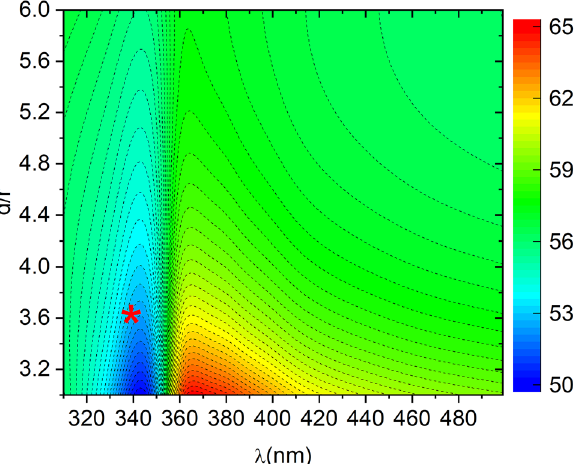
Figure 1. Color map of the polarization angle ( θ ) needed to obtain an equilibrium binding distance at d for each wavelength (cid:31) . Results are for r = 5 nm radius silver